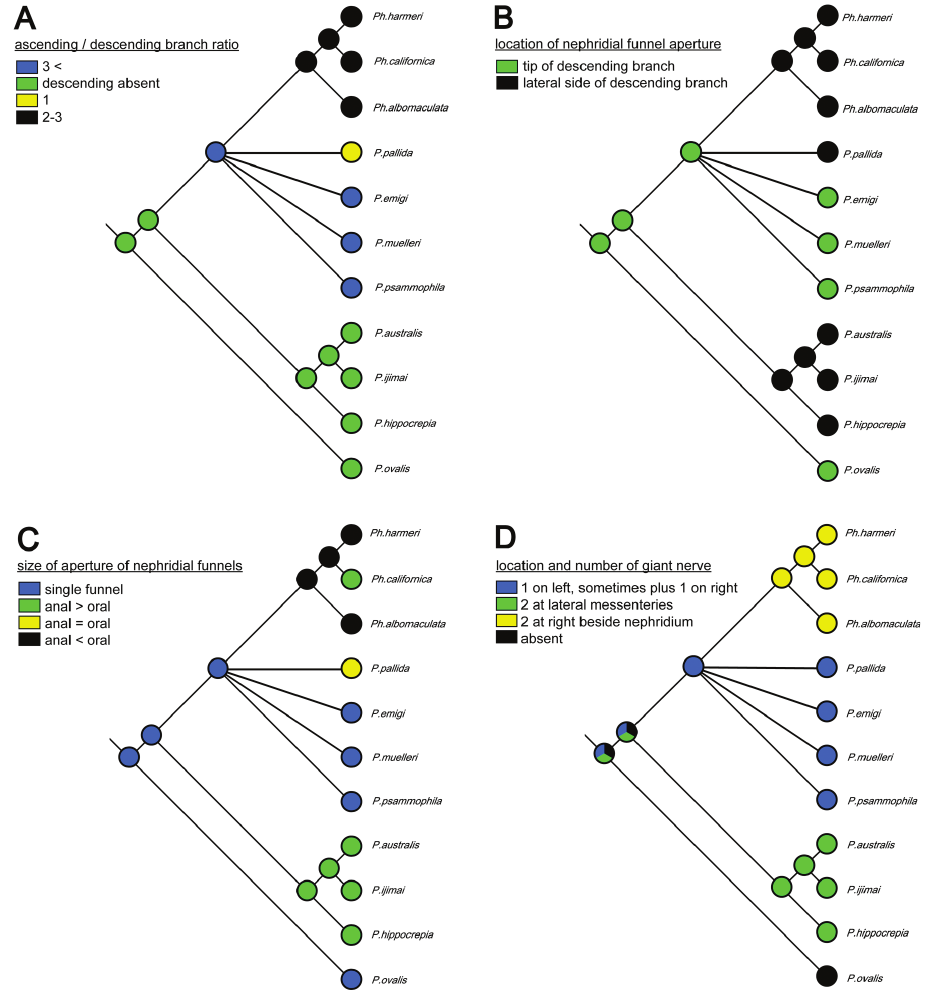
Supplementary Figure S4. Parsimonious reconstruction of four adult morphological characters among 11 phoronid species on the parsimonious consensus tree based on 32 morphological